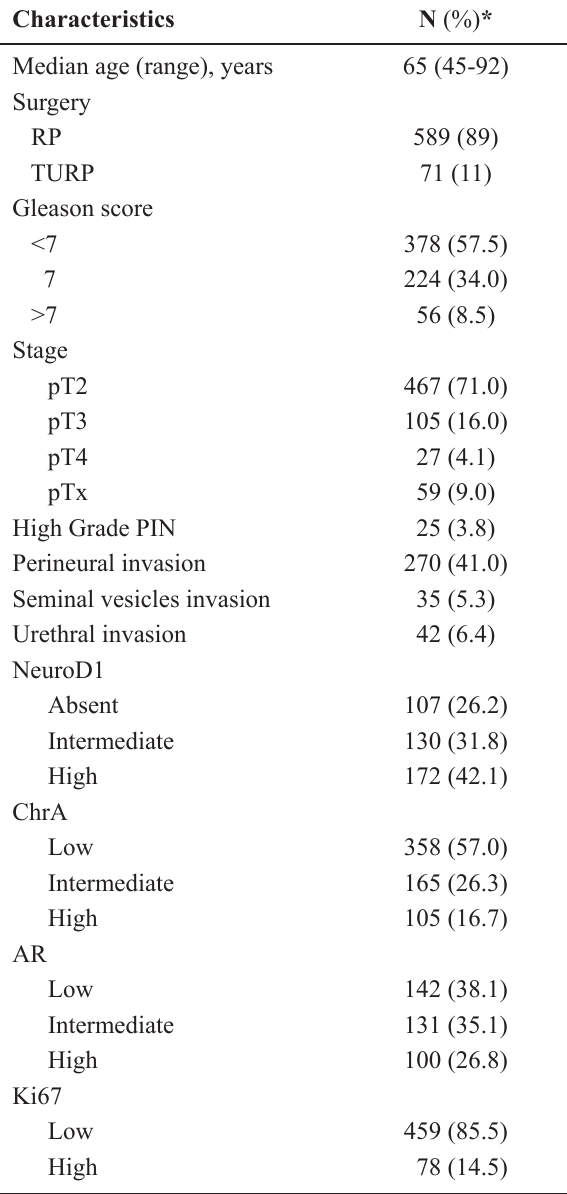
Table 1 – Main clinical and pathological findings of 658